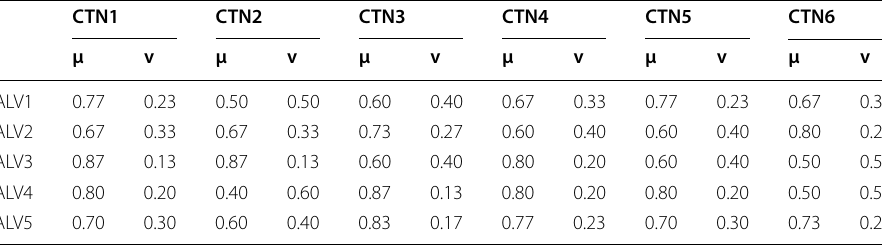
Table 11 Average values of the membership and non-membership degrees for the alternatives CTN1